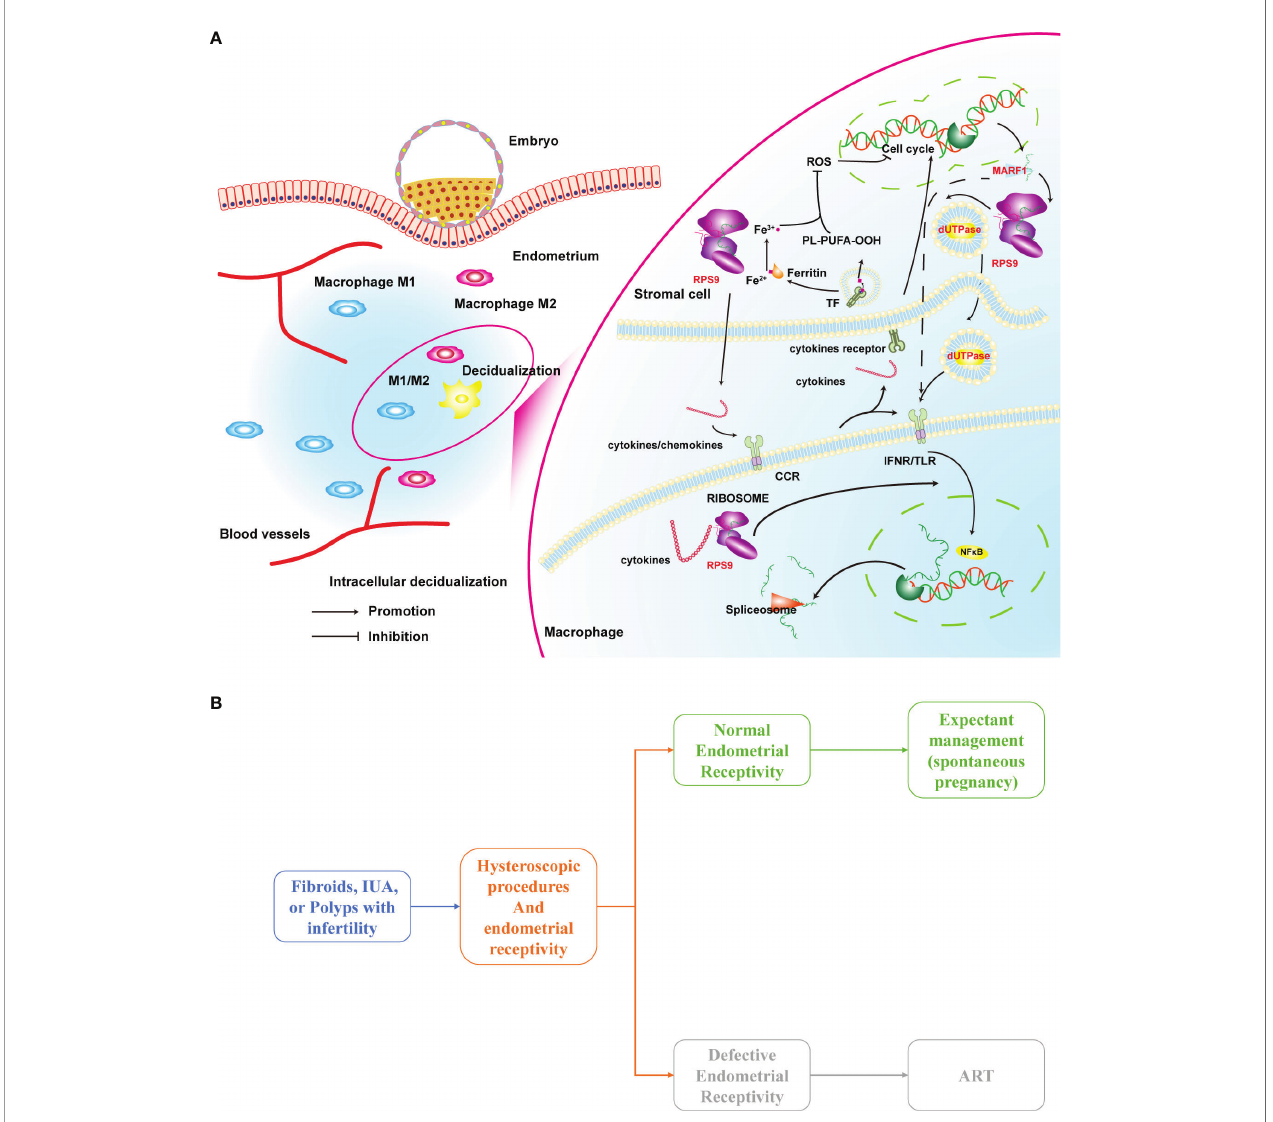
FIGURE 8 | (A) A hypothesis on the mechanism of macrophage-endometrium interaction modules regulation on endometrial receptivity and (B) a scenario for clinical application of the defective endometrial receptivity prediction model. ART, Assisted reproductive